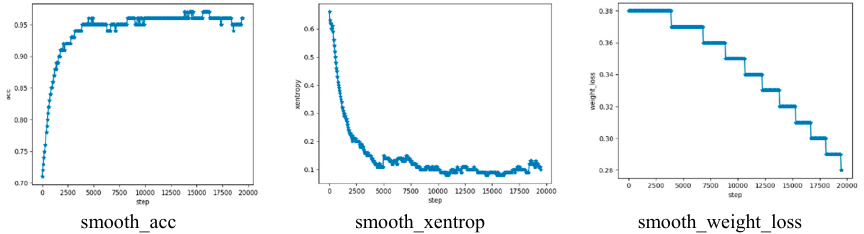
Figure 15 . Loss diagram. Figure 15. Loss diagram.